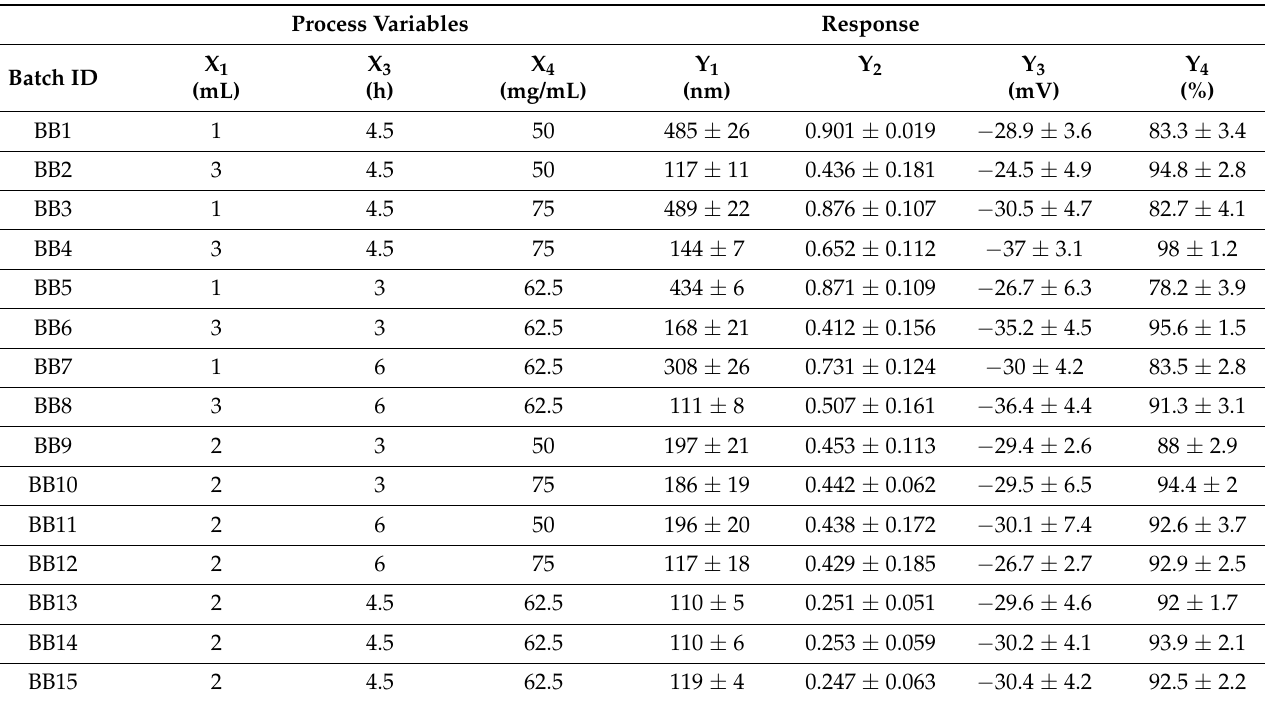
Table 8. Box–Behnken experimental design and its results: X 1 : Amount of EtOH (mL), X 3 : Incubation time (h), X 4 : Concentration of HSA (mg/mL), Y 1 : Z-average (nm), Y 2 : PdI, Y 3 : zeta potential (mV), and Y 4 : Yield (%). Data are presented as mean ± SD, ( n = 3). Process